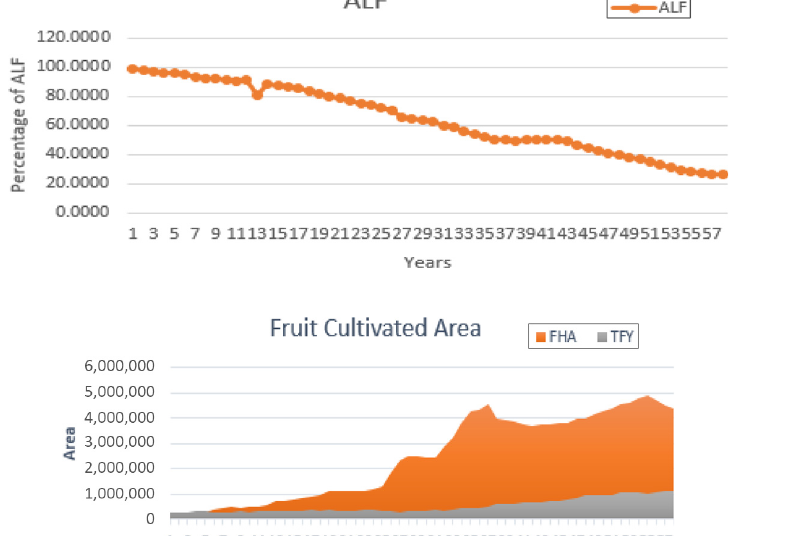
Figure 7. Fruit cultivated area